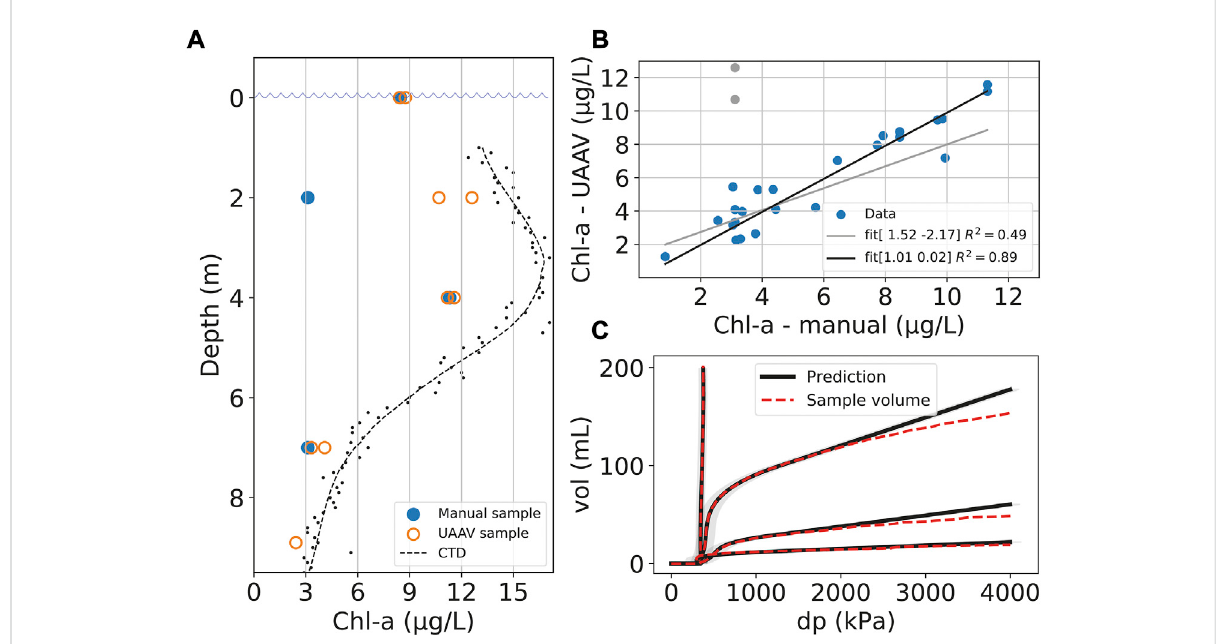
FIGURE 6 (A) Vertical section of the Chlorophyl-a values found at the Greifensee research station (47.366402, 8.665131) on the 30th of September 2021: manual sampling values obtained with a Niskin bottle, UAAV values obtained with MEDUSA and CTD values obtained using the automated multiparametric probe. (B) Correlation of UAAV - manual samples obtained in the same location/depth at several locations. In grey, the removed datapoints where a manual sampling error is likely to have occurred. (C) Evolution of fi ltered volume with differential pressure measued in the sampler, comparing volumes predicted using the linear model used in the sampler and the real measured volume. At 1,000 kPa, the limit for sample cut-off put in place to avoid non-linear